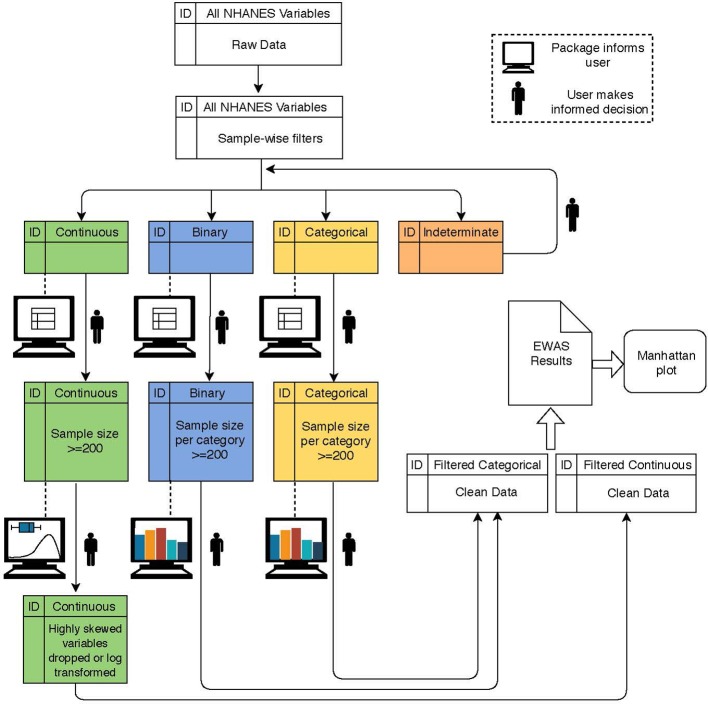
Flowchart depicting a typical workflow when using the CLARITE package. The user starts with raw data and alternates between summary steps (dashed lines) and filtering/quality control (QC) steps (solid lines) based on variable type (indicated by color) and either user-defined or default thresholds informed by the summary output. Once data are sufficiently cleaned, environment-wide association studies (EWAS) can be run.